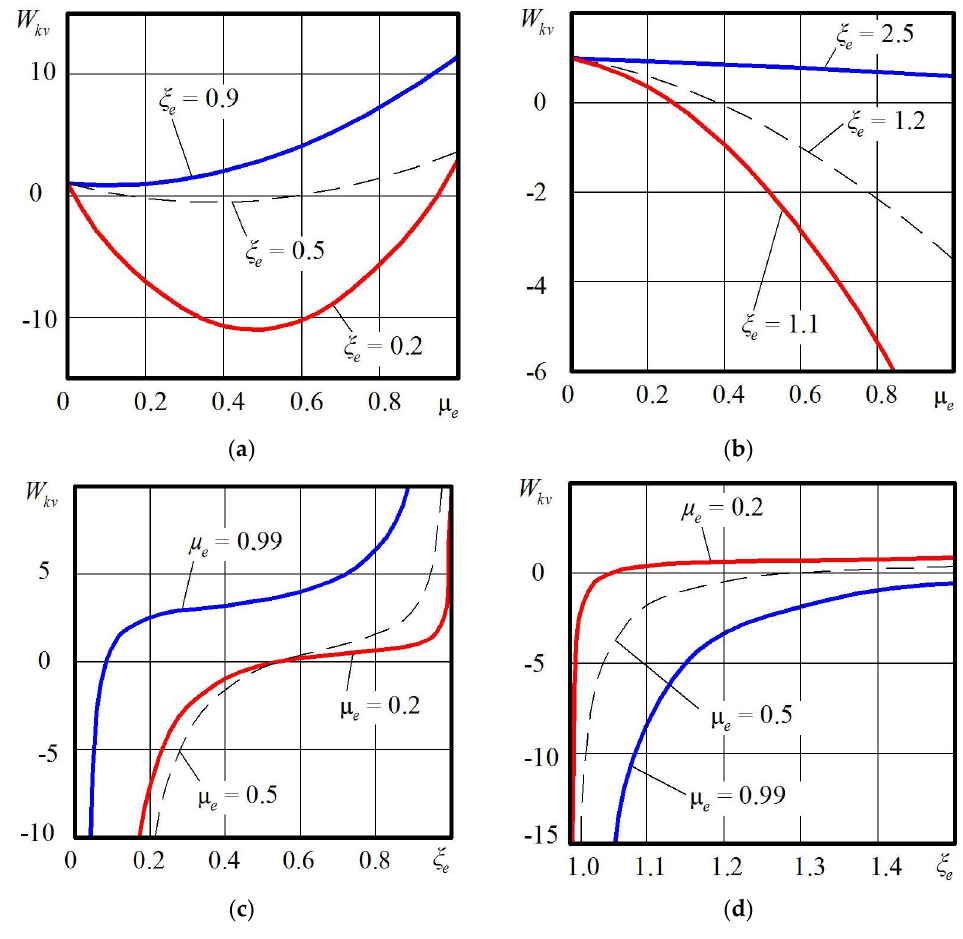
Figure 4. Function graphs: ( a , b ) − W kv = ( µ e ) ; ( c , d ) − W kv = ( ξ e ) .